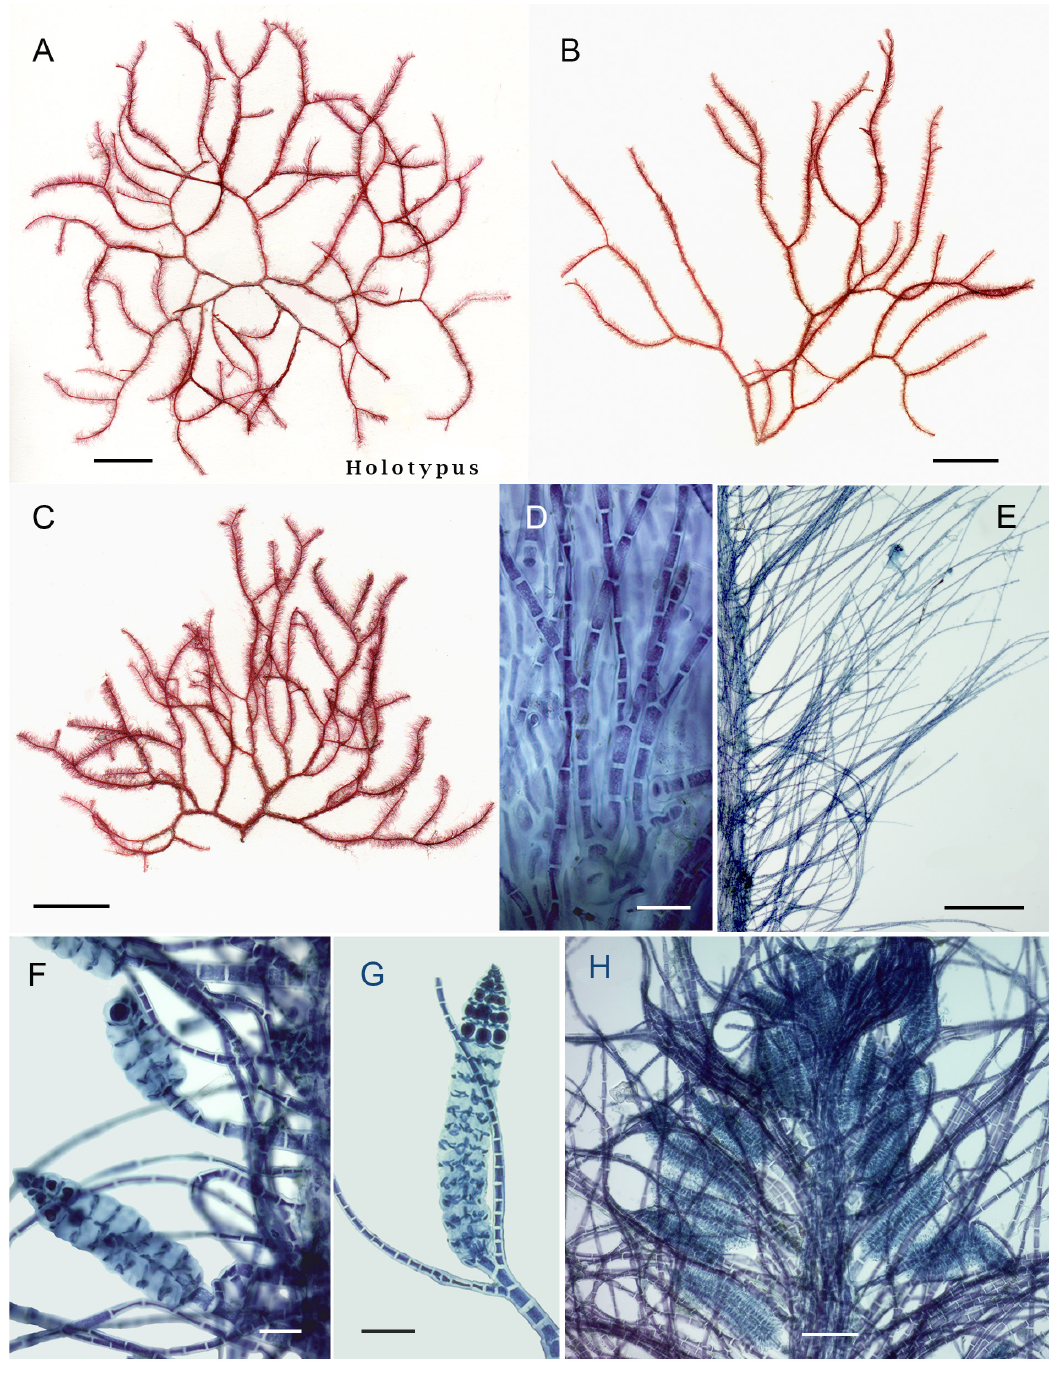
Fig. 2. Dasya sylviae C.W.Schneid., M.M.Cassidy & G.W.Saunders sp. nov. A . Holotype specimen, CWS / TRP 16-21-14 (BDA2031); MICH. B–C . Isotype specimens. D . Whole mount near apex with rhizoidal cortication and pseudolateral branches, CWS / TRP 16-17-2. E . Whole mount of axis with emerging pseudolaterals, CWS / TRP 16-21-14. F . Tetrasporangial stichidia on long pedicels, CWS / TRP 16-11-1 (BDA1969). G . Acropetal development in a tetrasporangial stichidium at base of pseudolateral branch with whorled two-celled branches bearing sporangia that lack post-sporangial cover cells, CWS / TRP 16-11-1 (BDA1969). H . Spermatangial stichidia at axis apex, CWS / TRP 16-21-14. Scale bars: A–C = 2 cm; D, F = 50 µm; E = 500 µm; G–H = 100